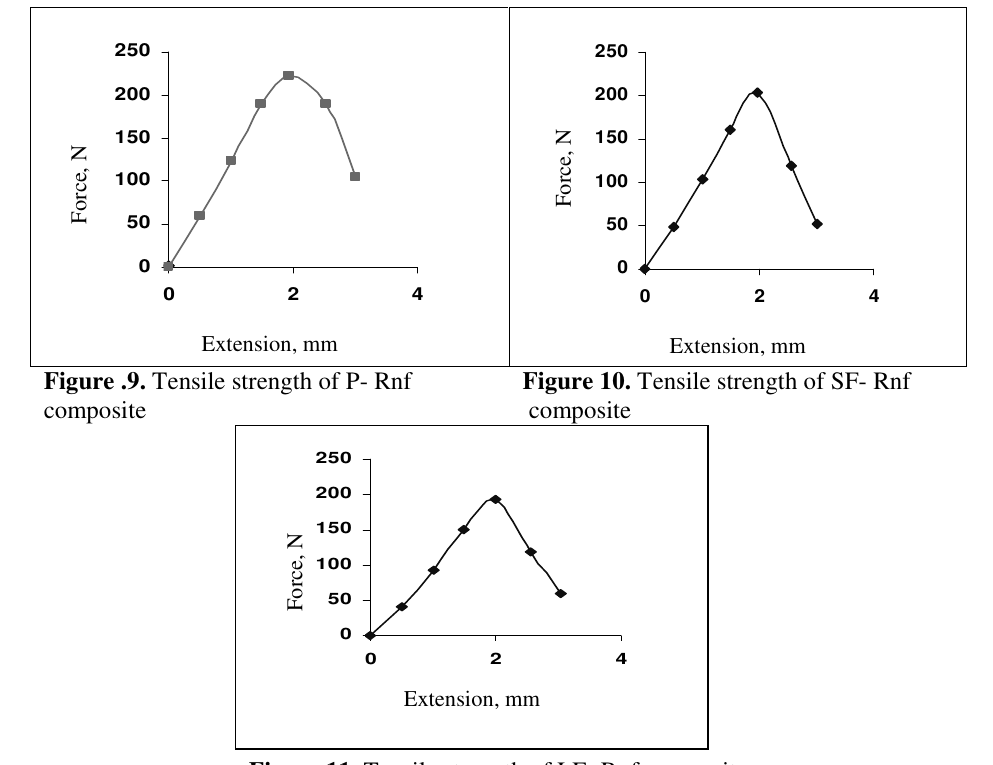
Figure 11. Tensile strength of LF- Rnf composite Wear Resistance